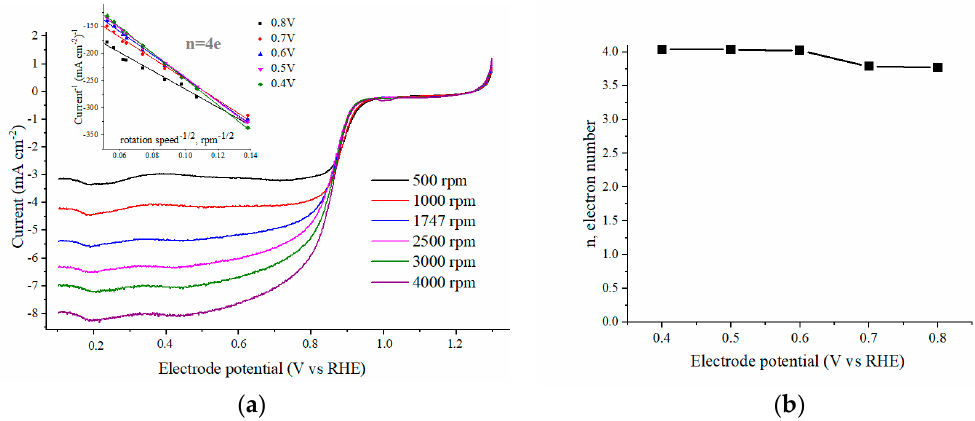
Figure 5. ( a ) Rotating disc voltammograms and (insert) Koutecký–Levich plots for the oxygen reduction on the Pt/Cu (PC) (sample 4 from Table 1) electrode at different potentials in O 2 -saturated 0.2 M NaOH solutions, ( b ) electron transfer number profile obtained from Koutecký–Levich plot.